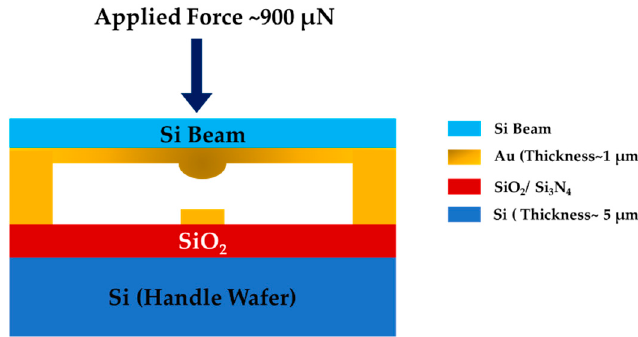
Figure 10. Schematic model for determining Au pillar dimensions.